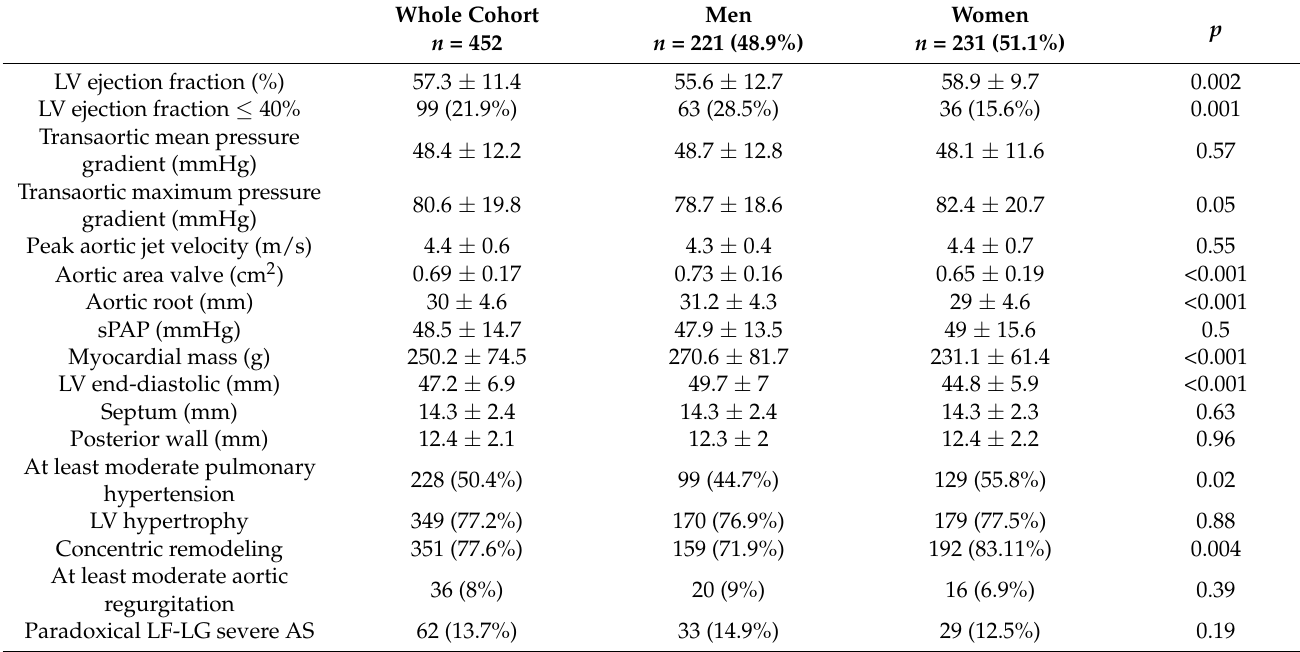
Table 2. Echocardiography